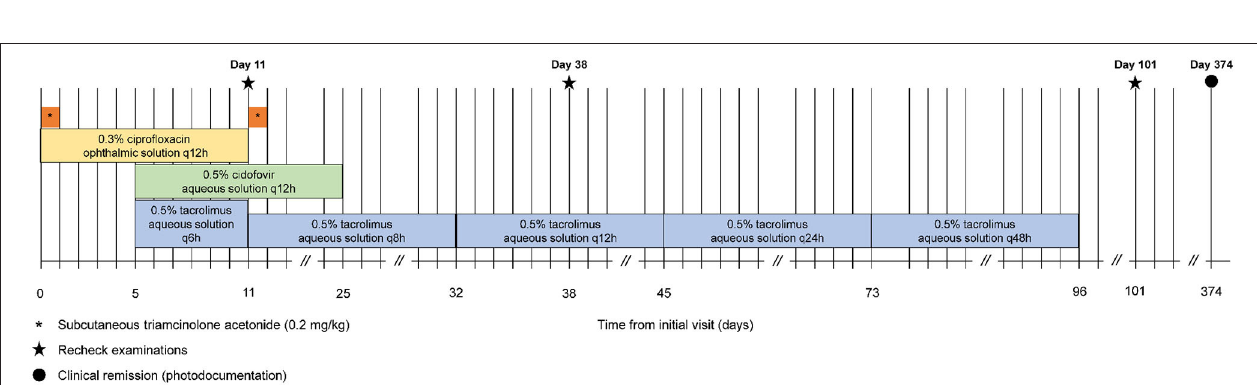
FIGURE 3 | Clinical images of the right eye (A) and left eye (B) of a cat with historical eosinophilic keratitis in clinical remission. Images were taken by the owner using a smartphone on Day 374 following initial diagnosis, that is, 278 days after discontinuation of all therapies.